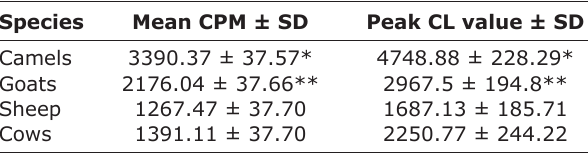
Table-1: Comparison of the luminol-dependent mean CPM and peak CL value of camels, goats, sheep, and cows. Species Mean CPM ± SD Peak CL value ± SD